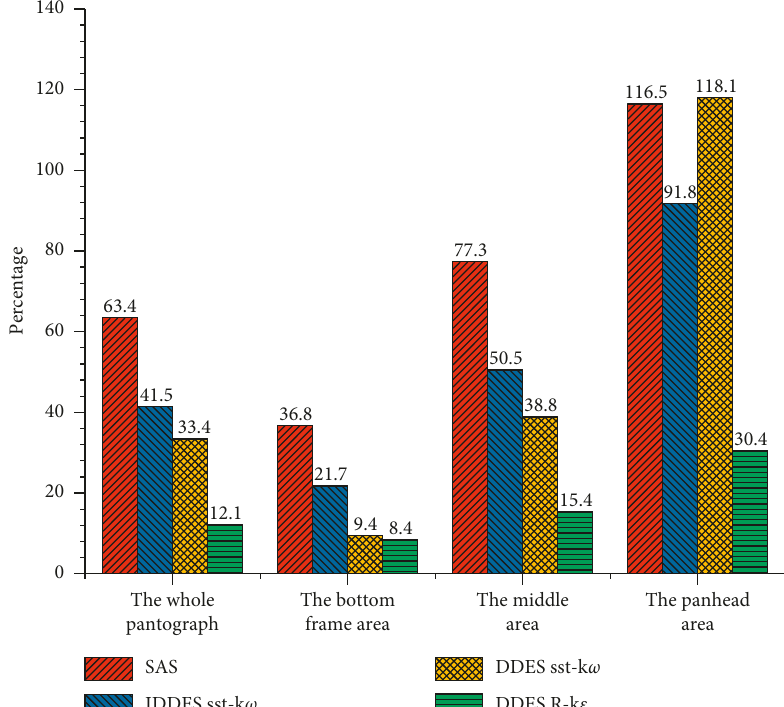
Figure 17: Percentage of equivalent radiated acoustic energy density of the four models at the standard observation point relative to LES (350 km/h).